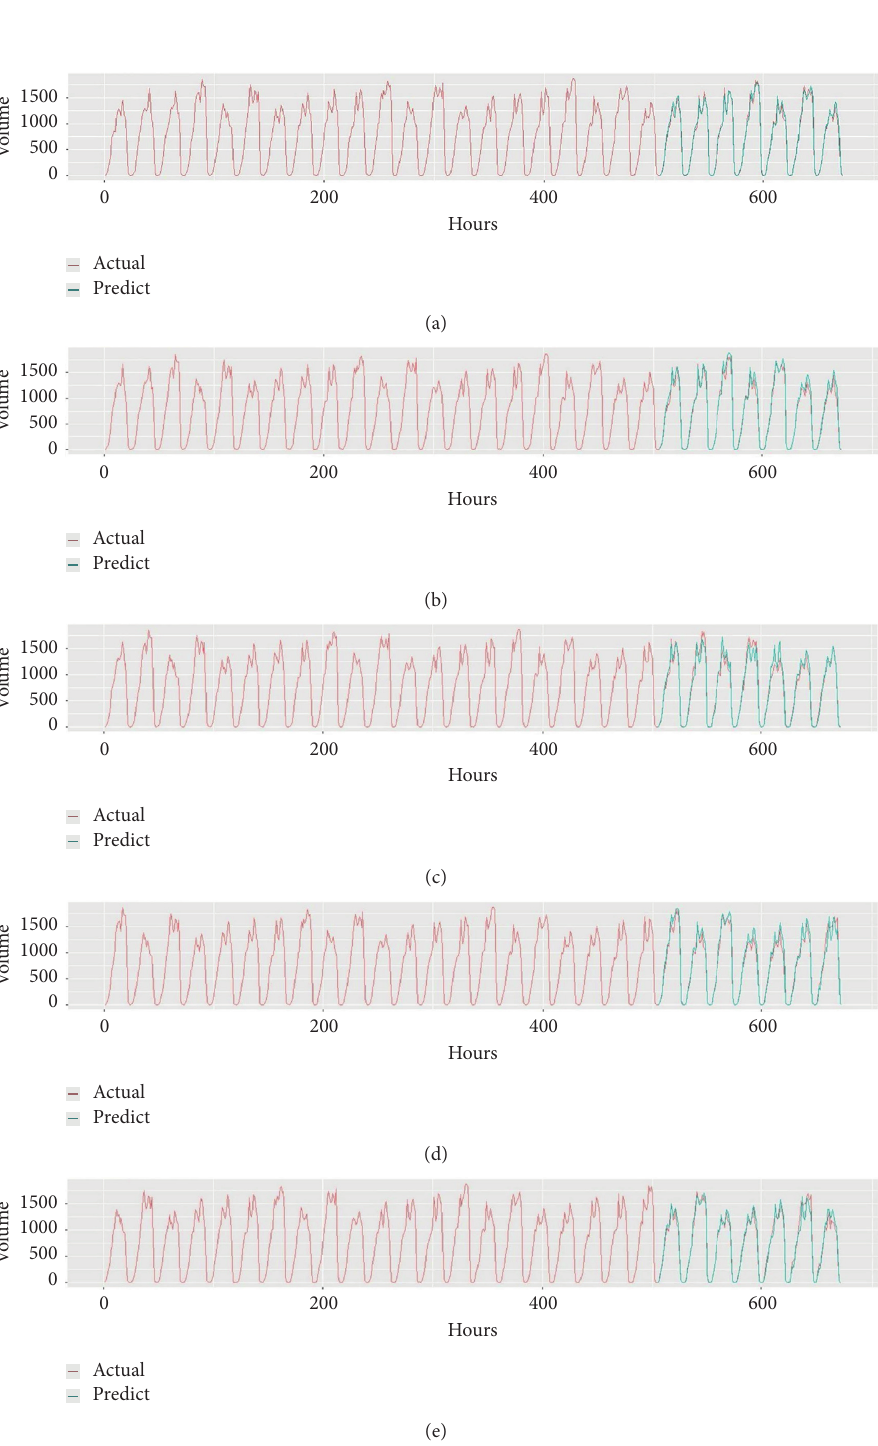
Figure 7: Forecast results of the parking duration category D1 of each slice. (a) D1, slice 2, and MRE: 14.89%. (b) D1, slice 3, and MRE: 12.52%. (c) D1, slice 4, and MRE: 14.39%. (d) D1, slice 5, and MRE: 12.76%. (e) D1, slice 6, and MRE: